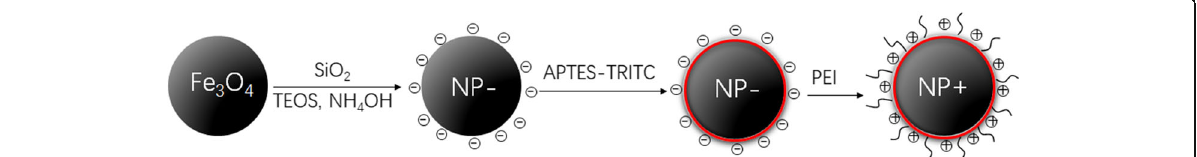
Fig. 1 Design of the nanoparticles. Schematic diagram showing the design of surface-charged, fluorescent, superparamagnetic composite nanoparticles